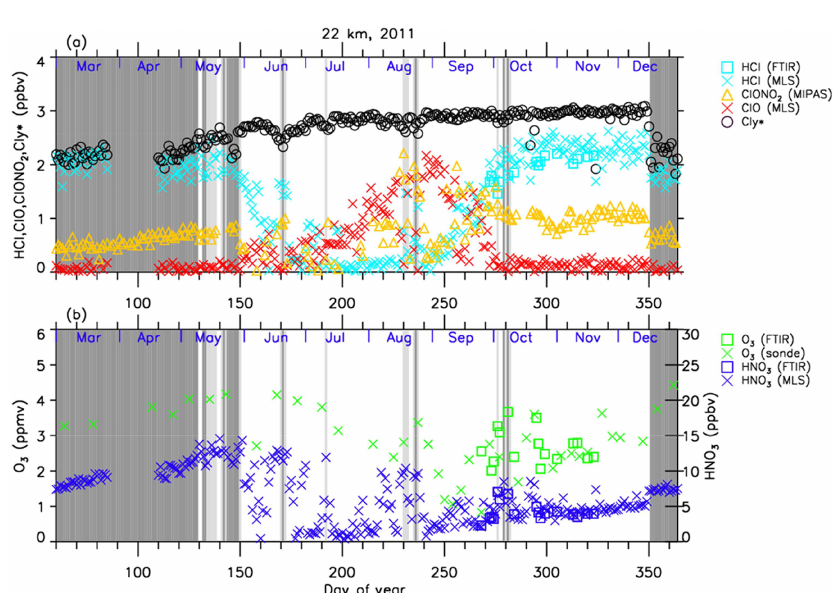
Figure 7. Same as Fig. 5 but at